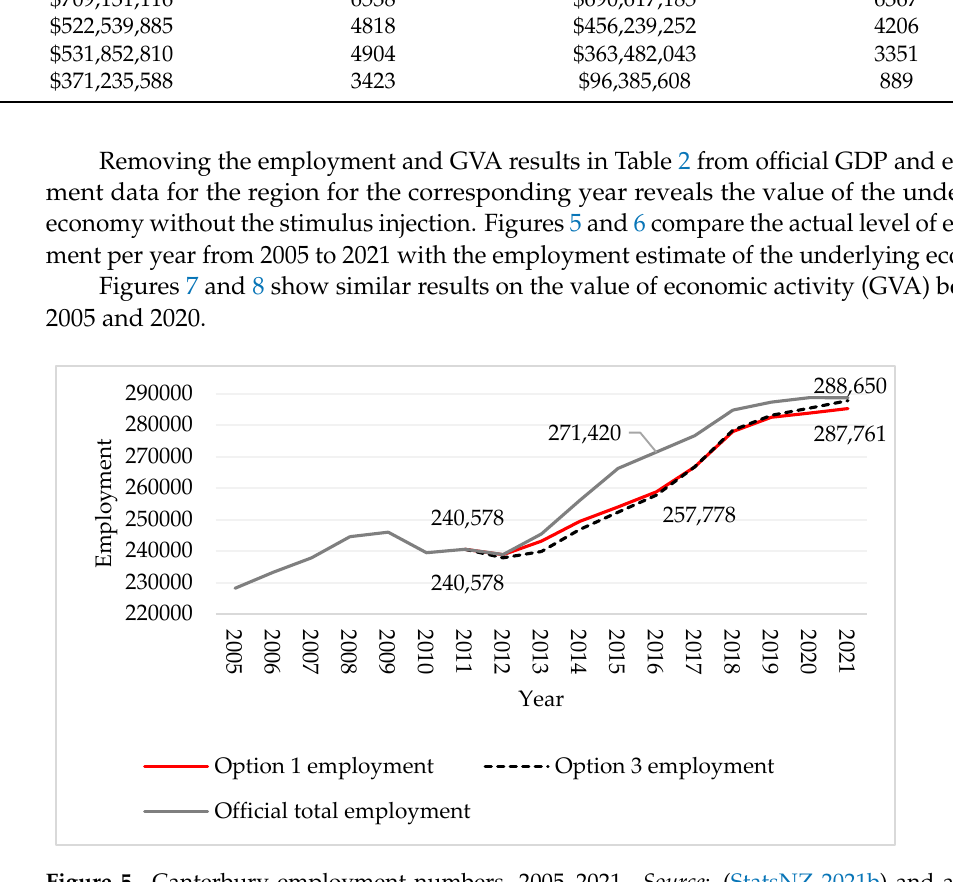
Figure 5. Canterbury employment numbers, 2005–2021. Source : (StatsNZ 2021b) and author’s calcu- lations.